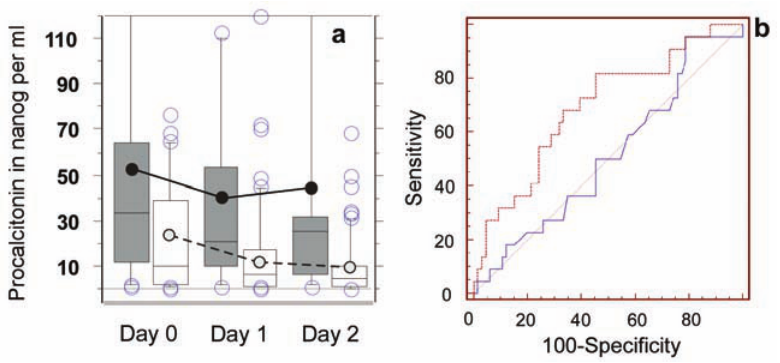
Figure 3. Kinetic and ROC curves of PCT values in individuals with cerebral malaria. Shown are the magnitude and kinetic of individual level of PCT on day 0, 1 and 2 as box plot (a). Fatal cases (dark grey) show higher levels and less decrease of PCT values than surviving individuals (light grey). Mean values are plotted as plain lines (fatal cases) and dashed lines (surviving). In part b) is shown the ROC curves for PCT values (dashed) and haemoglobin (plain) plotting sensitivity as function of 100-specificity. Optimal values are 69.2 ng/mL for specificity, and 30 ng/mL for both specificity and